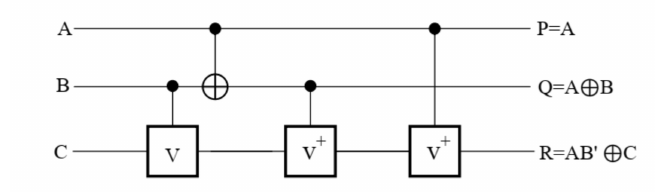
Figure 9. The quantum implementation TR